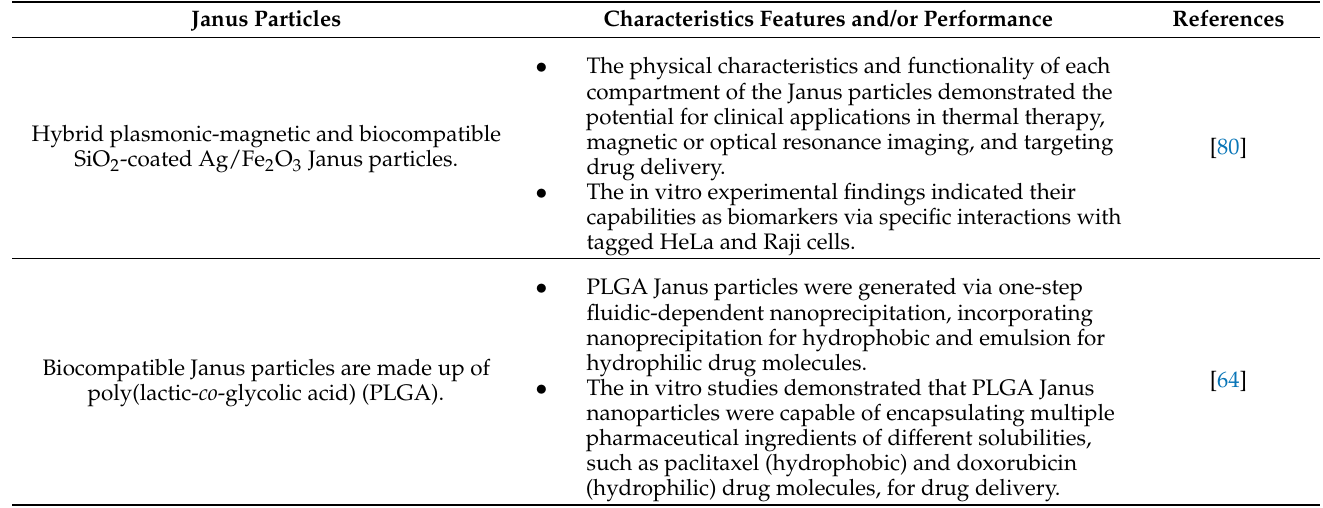
Table 2. Janus particles as an effective drug-delivery system for the treatment of various diseases. Janus Particles Characteristics Features and/or